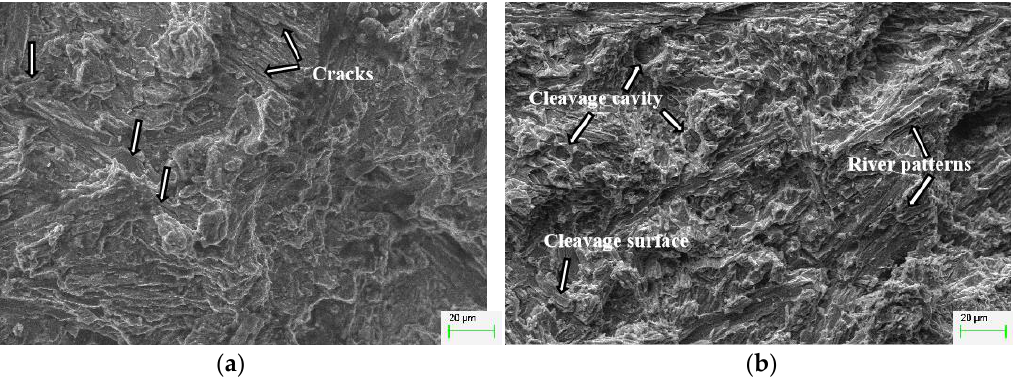
Figure 7. Impact fracture of JY630 and JY500 observed using the scanning electron microscope after. ( a ) 630 °C-quenching; ( b ) 500 °C-quenching.